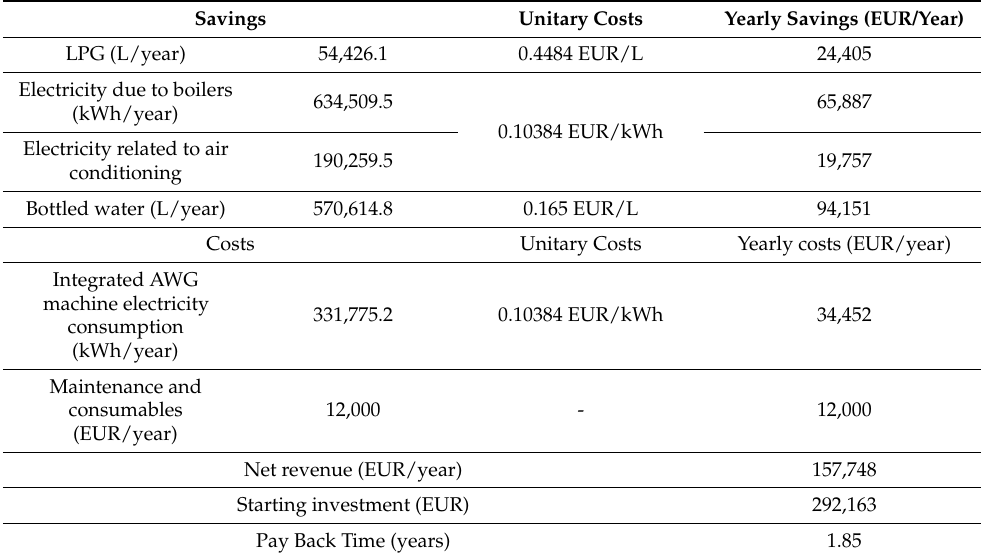
Table 4. Savings, costs and net revenue of the investment related to the integrated AWG